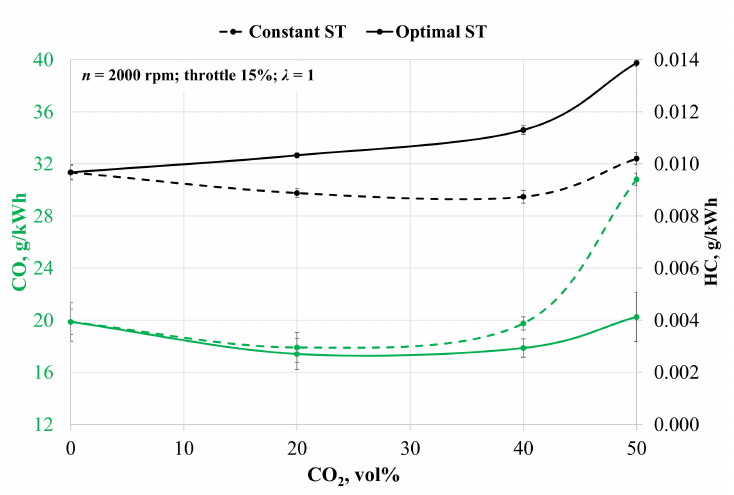
Figure 7. Change of the carbon monoxide and HC concentration in exhaust gas depending on the volumetric fraction of CO 2 .